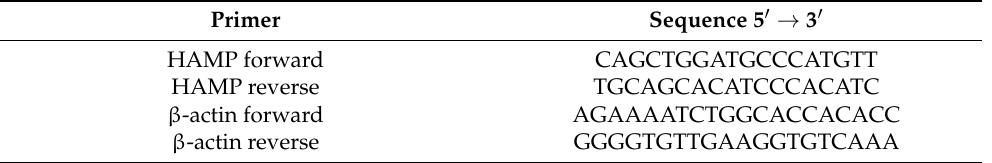
Table 1. Primers used in the